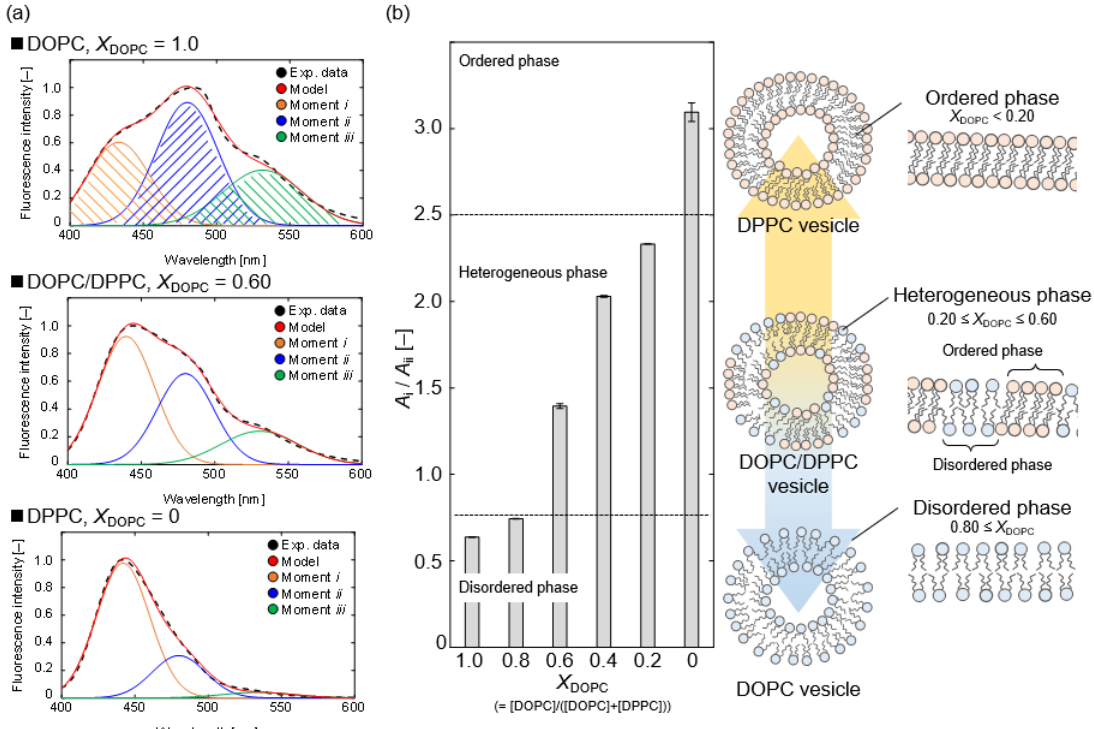
Figure 4. ( a ) Deconvolution results of Laurdan spectra by the measurement of a 2 mM DOPC vesicle, a 2 mM DOPC/DPPC vesicle ( X DOPC = 0.60), and a 2 mM DPPC vesicle at 298 K. The experimental data (black) are fitted by the model (red), which consisted of moment i (orange), moment ii (blue), and moment iii (green), respectively. ( b ) The relationship between X DOPC and A i / A ii ratio in the vesicles at 298 K. The effect of the molecular structure of the phospholipids on the phase state of their vesicle is